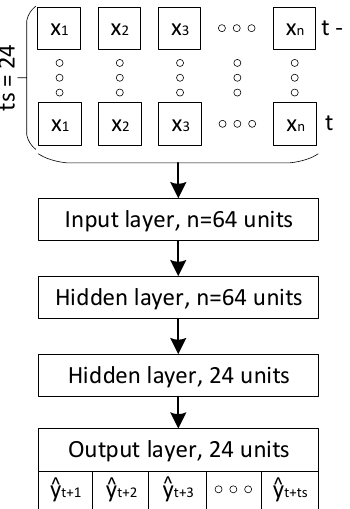
Figure 9. Architecture of the 3-layer ANN model.